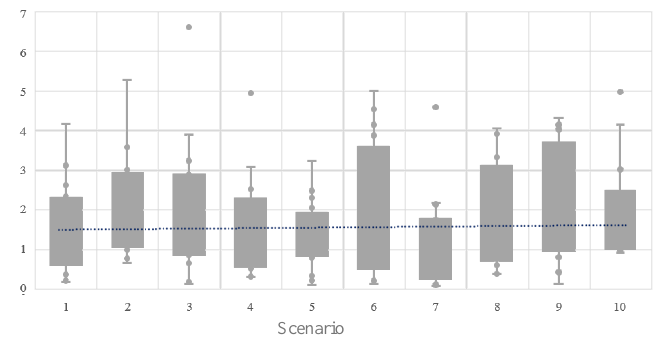
Figure 3. Investment costs ( € ) for each scenario.